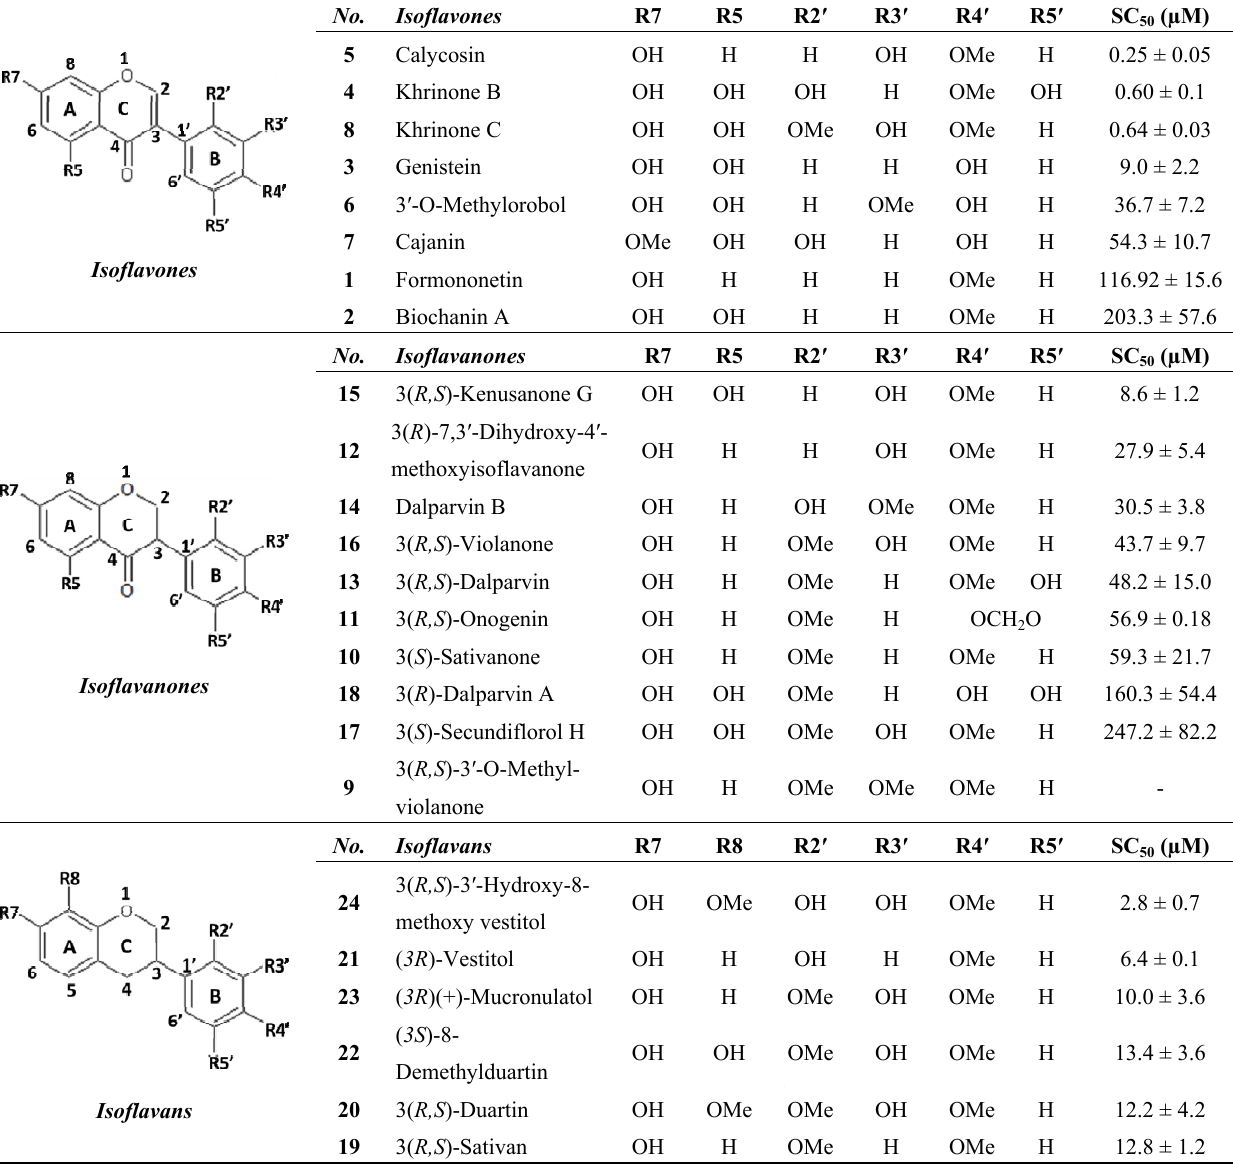
Table 1. SAR of D. parviflora isoflavonoids based on the xanthine/xanthine oxidase assay.